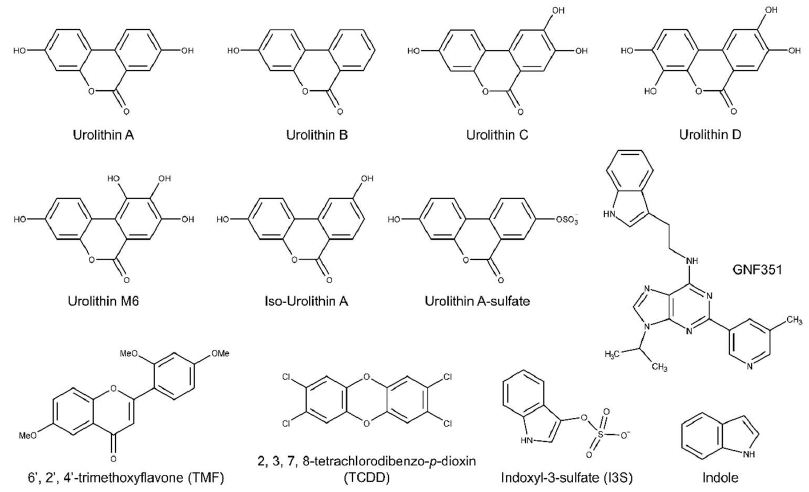
Figure 1. Structures of the urolithins and AHR ligands used in this study.